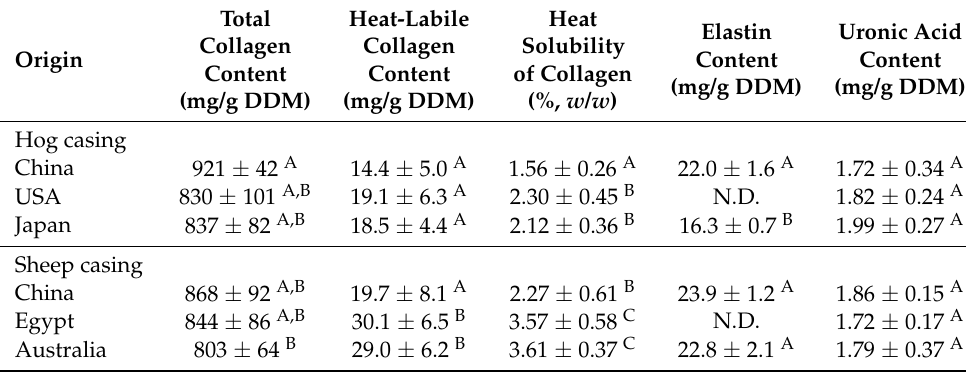
Table 2. Biochemical characteristics of natural hog and sheep